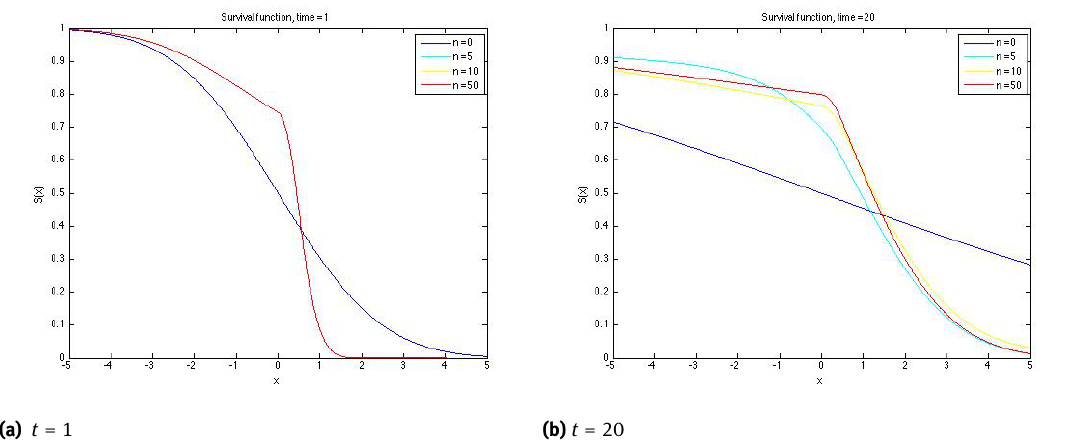
Figure 5: Survival function of X − Y n in the multi-barrier correlation model at time t with parameters ν = 0, η = 0.5 and ρ = 0.9 for different values of